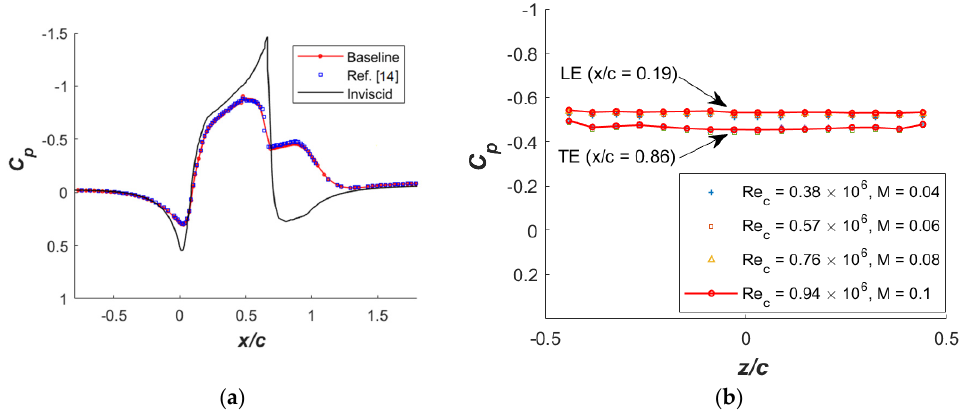
Figure 3. Surface static pressure distribution over the hump model: ( a ) centerline pressure distribution; ( b ) spanwise pressure distribution at the leading and trailing edge of the model for different Reynolds numbers.